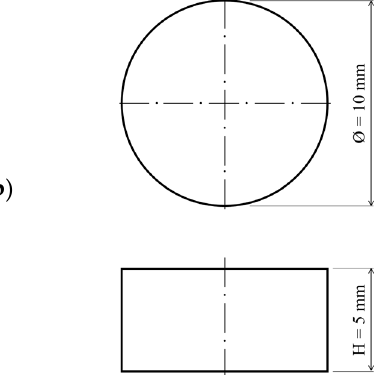
Figure 1. ( a ) Three-dimensional model of imported cylinder design and ( b )